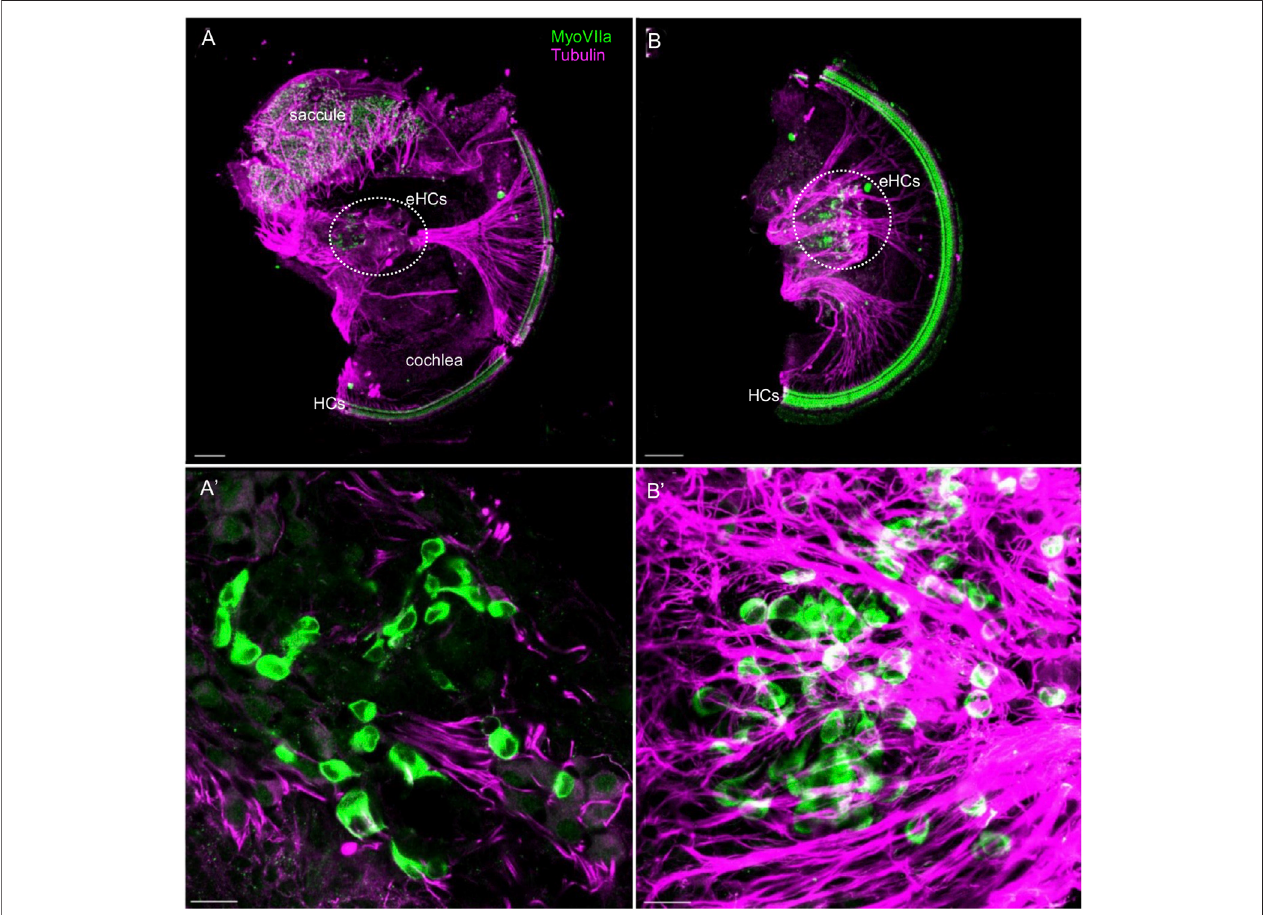
FIGURE10| Ectopichaircellsdifferentiateoutsidethesensoryepitheliainthe Neurod1CKO innerear.Representativeimagesofwholemountimmunolabelingwith MyosinVIIa (MyoVII, a marker of hair cells) and tubulin (neuronal fi bers) show hair cells in the saccule and rows of hair cells forming the organ of Corti in the Neurod1CKO cochlea. Ectopic MyoVIIa positive cells (eHCs) are found near the saccule and the aberrant cochlear ganglion (a dotted line delineates the area). Larger magni fi cation images show eHCs entangled with neuronal fi bers, and some cells are double-labeled for tubulin and MyoVIIa. Scale bars: 100 µm (A , B) ; 20 μ m (A ’ , B ’ ) .